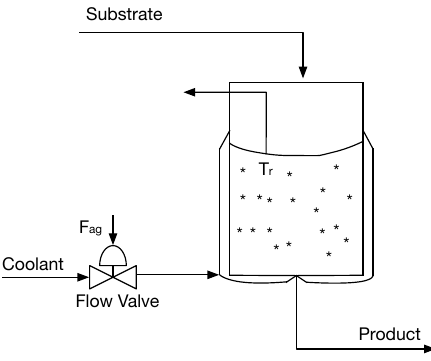
Figure 4. Setup of the continuous fermentation reactor.